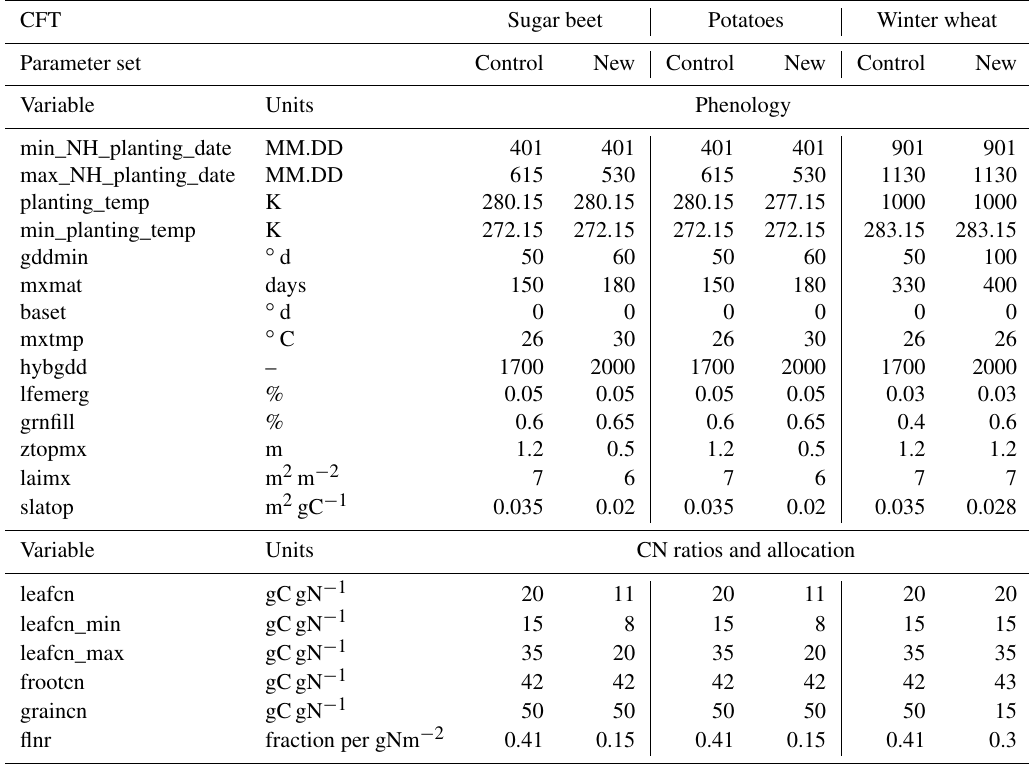
Table A2. Default (control) and new crop-specific (new) phenology and CN allocation parameters for the CFTs sugar beet, potatoes (control parameters are those for the CFT spring wheat), and winter wheat.